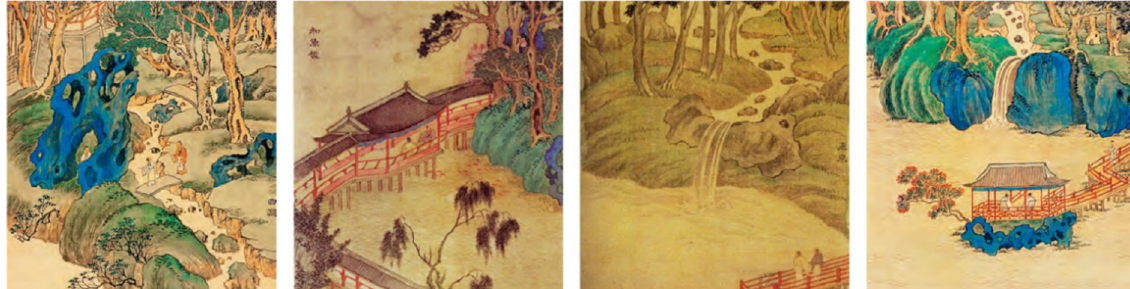
Figure 4. From the “Atlas of the Garden of Ji Chang “ (left to right): Qujiang, Jiji Fish Crest, Feichuan and Hanbi Pavilion (source: Sung Mao-chin).